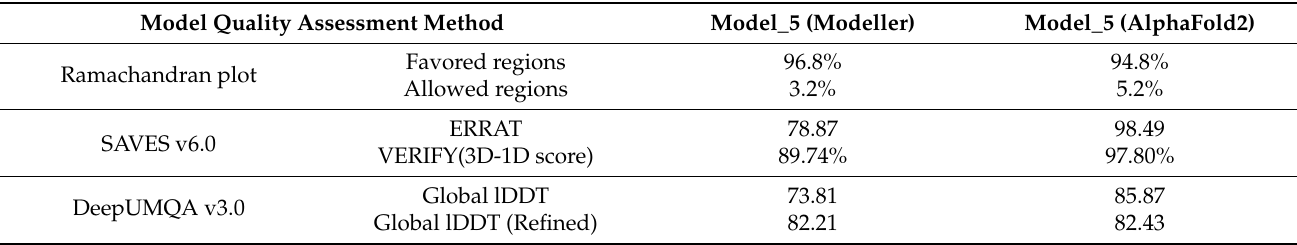
Figure 1. Modeling structure of pS273R. ( A ) Structural model of pS273R produced by ColabFold- alphaFold2 (blue, model_5) and Modeller 10.4 (green, model_5). ( B ) Ramachandran plot of pS273R model by Modeller 10.4. ( C ) Ramachandran plot of pS273R model by ColabFold-alphaFold2. Table 1. Evaluation and scoring of the pS273R model.